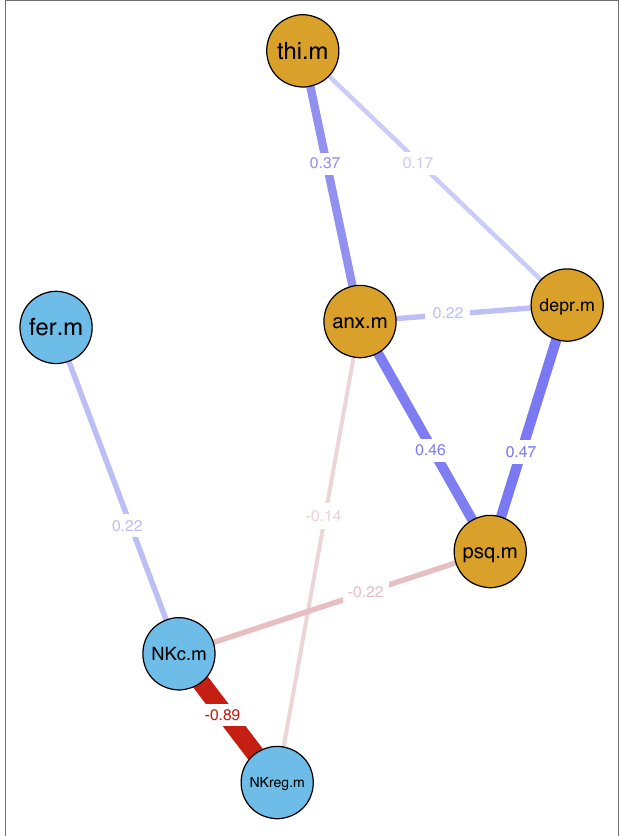
FIGURE 3 | LASSO regularized averaged cross-sectional network estimation for identified associations between psychological factors and natural killer cells. Blue lines indicate positive and red lines negative associations; line width indicates association strength. Network estimation was based on averaged variable values across all repeated measurement sessions (baseline, 7.8-week follow-up, 13.8-week follow-up). Nodes: anx.m = mean HADS anxiety; depr.m = mean HADS depression; NKc.m = mean NKc frequency; NKreg.m = mean NKreg frequency; psq.m = mean PSQ-20 total score; thi.m = mean THI total score. HADS, Hospital Anxiety and Depression Scale; NKc, Cytotoxic Natural Killer Cells; NKreg, Regulatory Natural Killer Cells; PSQ-20, Perceived Stress Questionnaire (20-item version); THI, Tinnitus Handicap